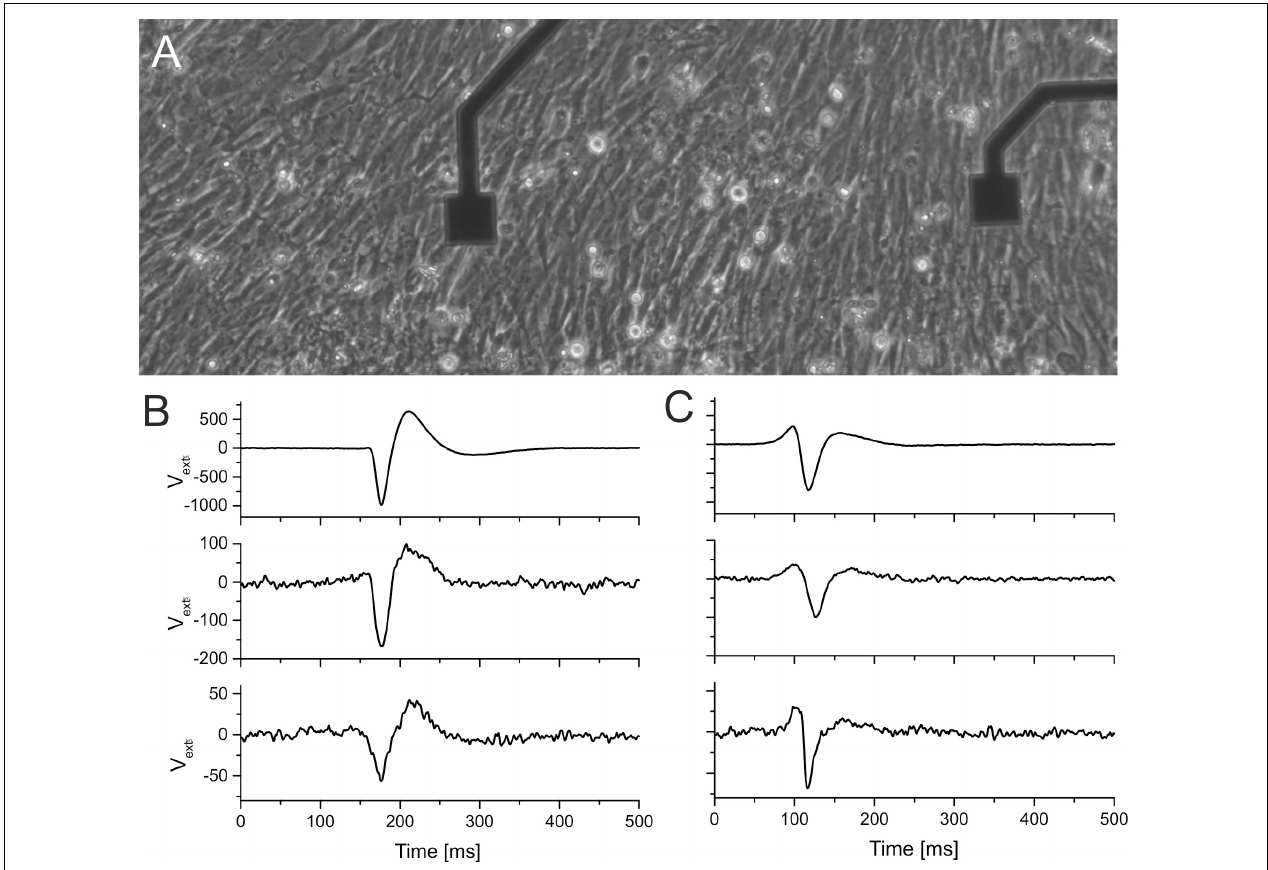
FIGURE 4 | Comparison of signal shapes recorded by TiN electrodes and by insulated (ALD-coated) TiN electrodes. (A) Micrograph of cardiomyocytes grown on HfO 2 -coated smooth TiN microelectrodes. The electrodes have an edge size of 40 µ m. (B,C) Extracellular signals recorded on three different electrodes. The first row in panels (B,C) shows signals recorded using a commercial electrode (fractal TiN). The second row in panels (B,C) shows signals recorded on electrodes where the smooth TiN had been coated with 15 nm of TiO 2 . The third row shows signals recorded on smooth TiN electrodes coated with HfO 2